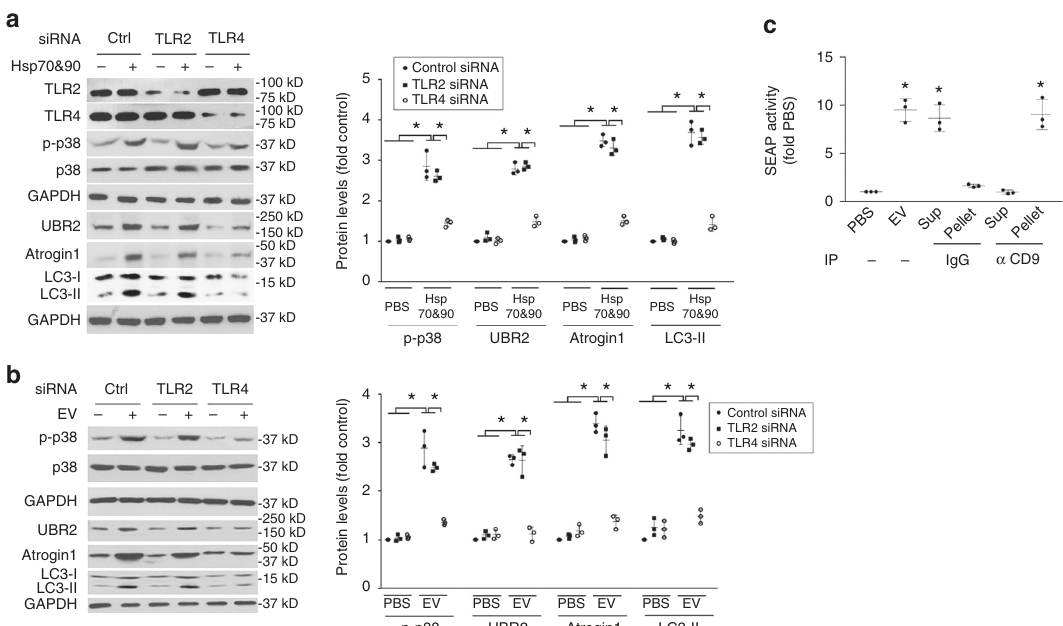
Fig. 8 TLR4 mediates Hsp70/Hsp90-induced catabolic response in myotubes. a Hsp70 and Hsp90-induced catabolic response in myotubes is dependent on TLR4. C2C12 myoblasts were transfected with siRNA as indicated. After differentiation, myotubes were treated with rHsp70 and rHsp90 and